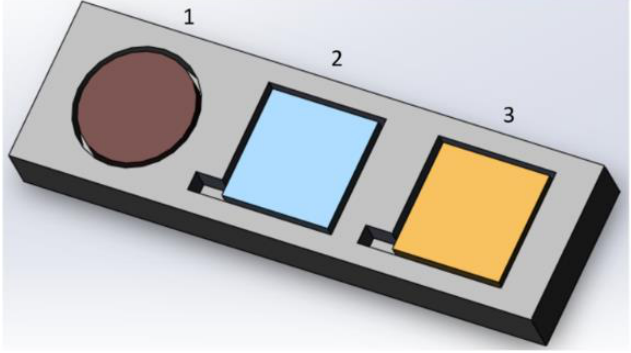
Figure 6. Polish dispenser.